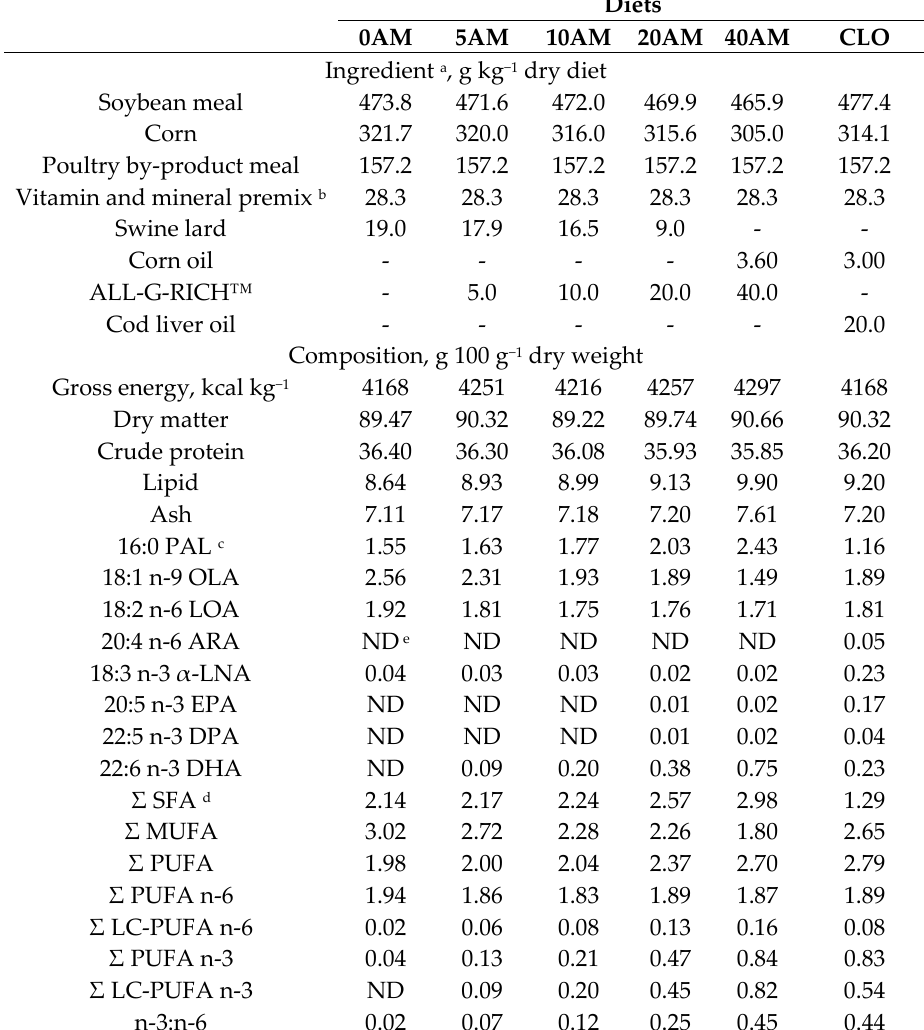
Table 1. Formulation, proximate composition, and fatty acid profile of the experimental